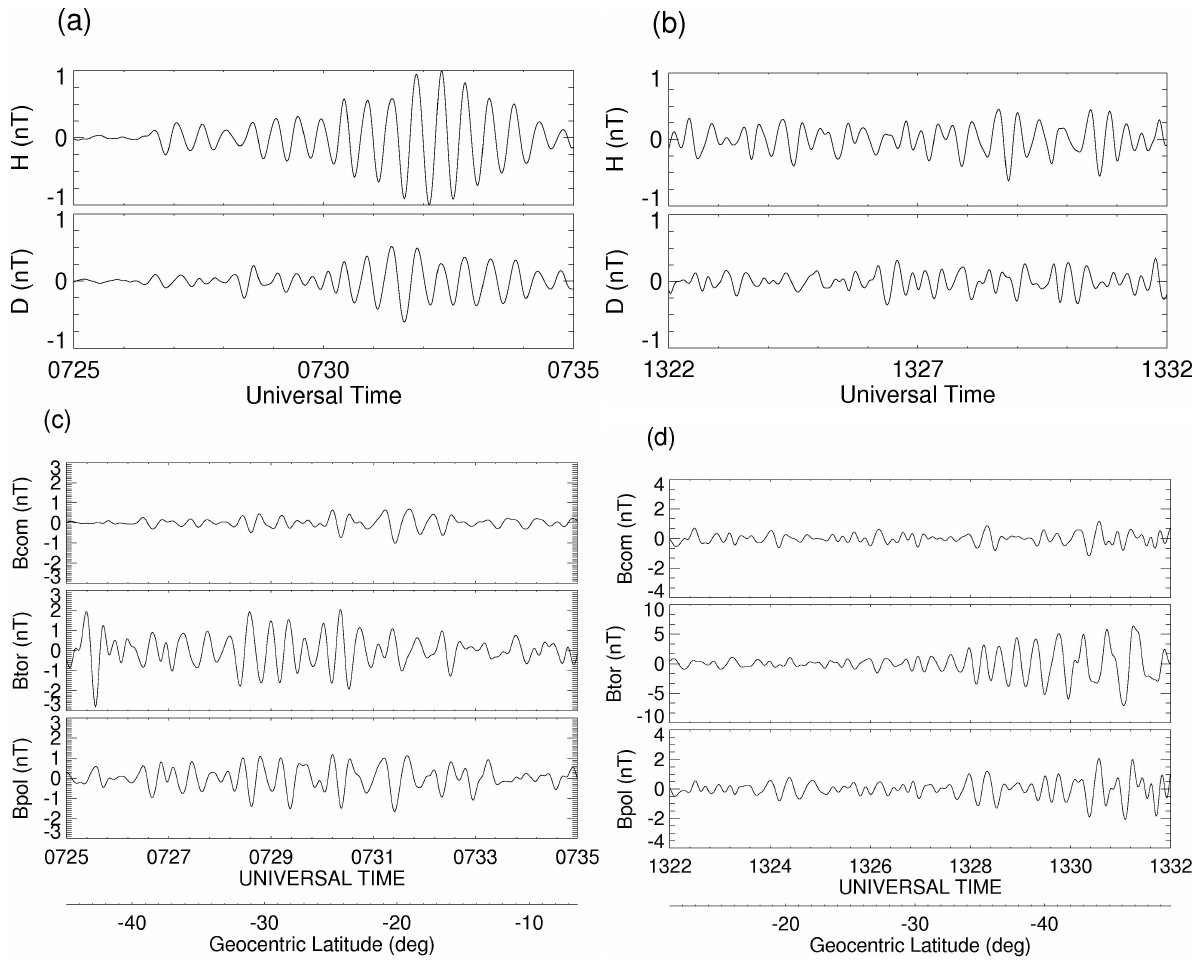
Fig. 3. The pulsation signals observed simultaneously on ground and along CHAMP trajectory. H- and D-components of the Pc3 pulsation activities observed on the ground on (a) 13 February 2002 and (b) 18 February 2003. Two Pc3 signals observed along the CHAMP satellite trajectories on (c) 13 February 2002 and (d) 18 February 2003. The CHAMP vector magnetic components shown are in a field-aligned coordinate system i.e. compressional ( B com ) , toroidal ( B tor ) and poloidal ( B pol ) , from top to bottom.